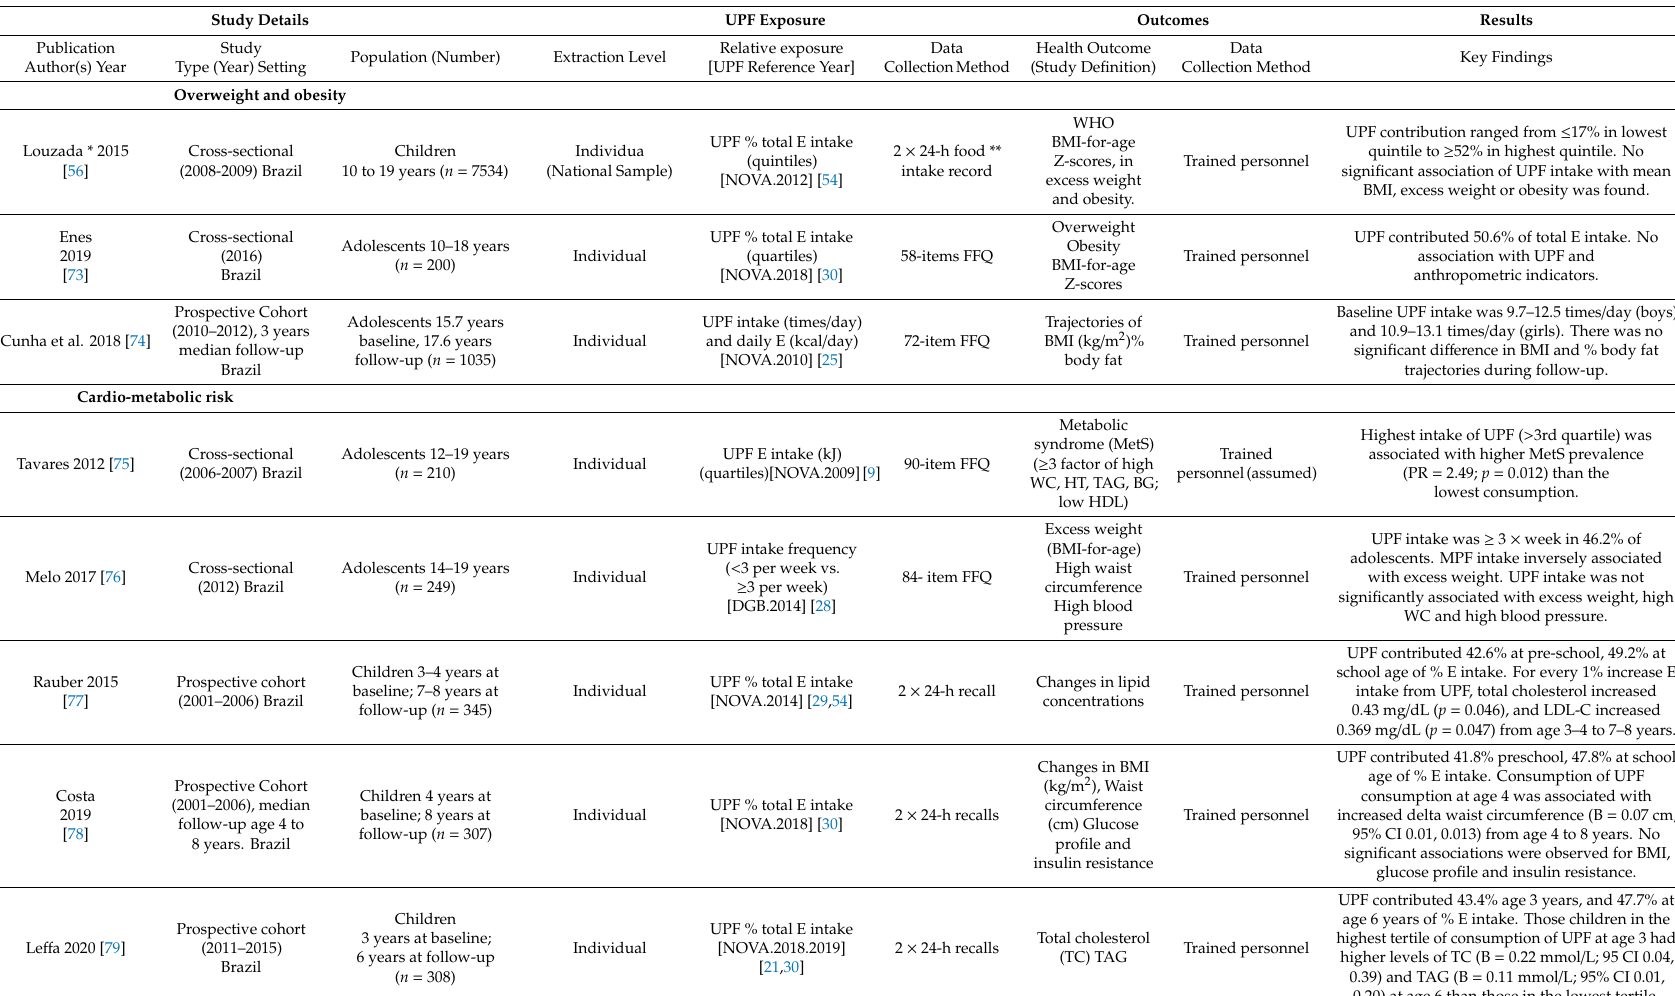
Table 3. Overweight, obesity and cardio-metabolic risks as outcome (children and